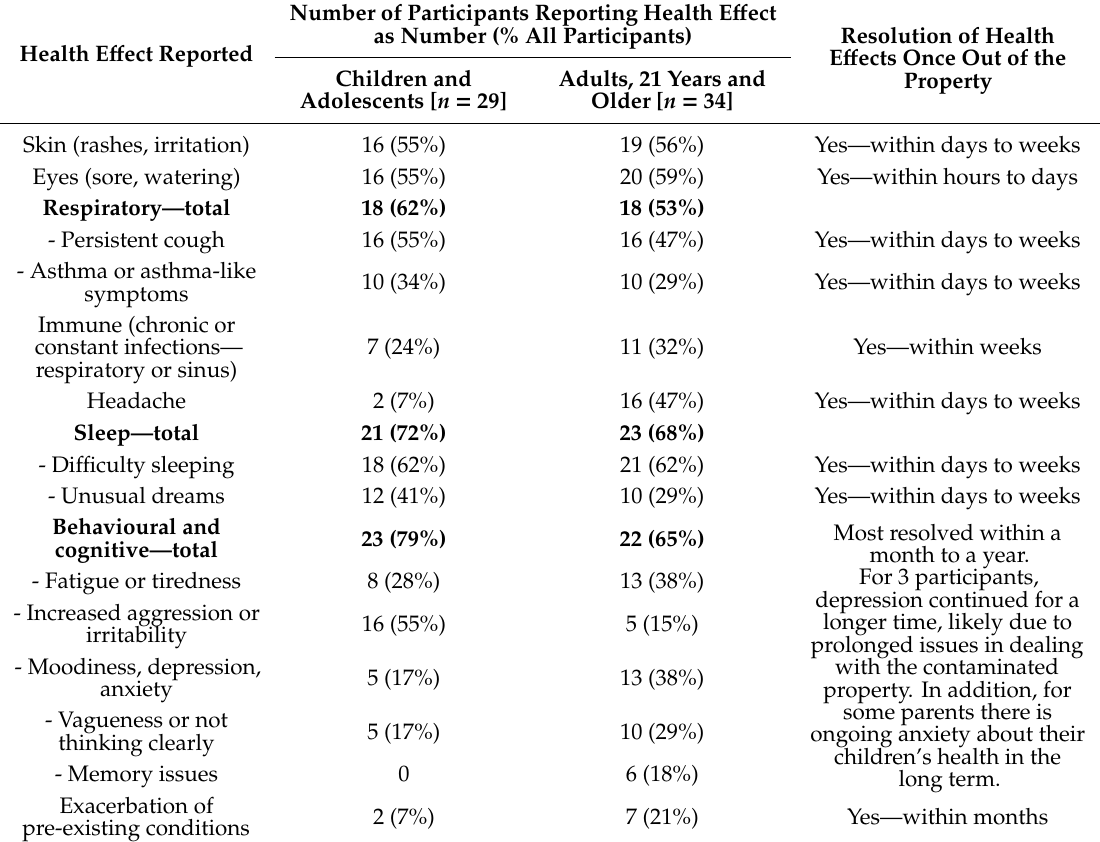
Table 3. Prevalence of health e ff ects reported by study participants when exposed in contaminated